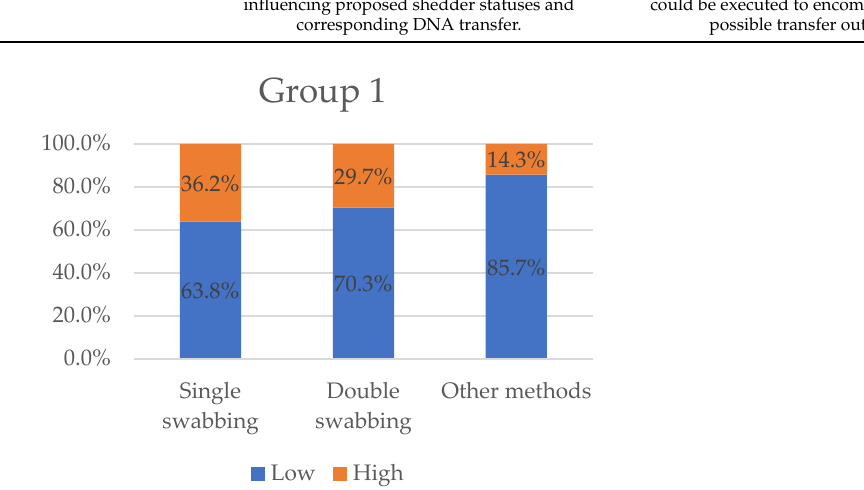
Figure 3. Variables “low” and “high” grouped by sampling methods for Group 1. With 36.2%, single-swabbing obtains the greatest “high” value, followed by double-swabbing (29.7%), and other methods (14 . 3%).